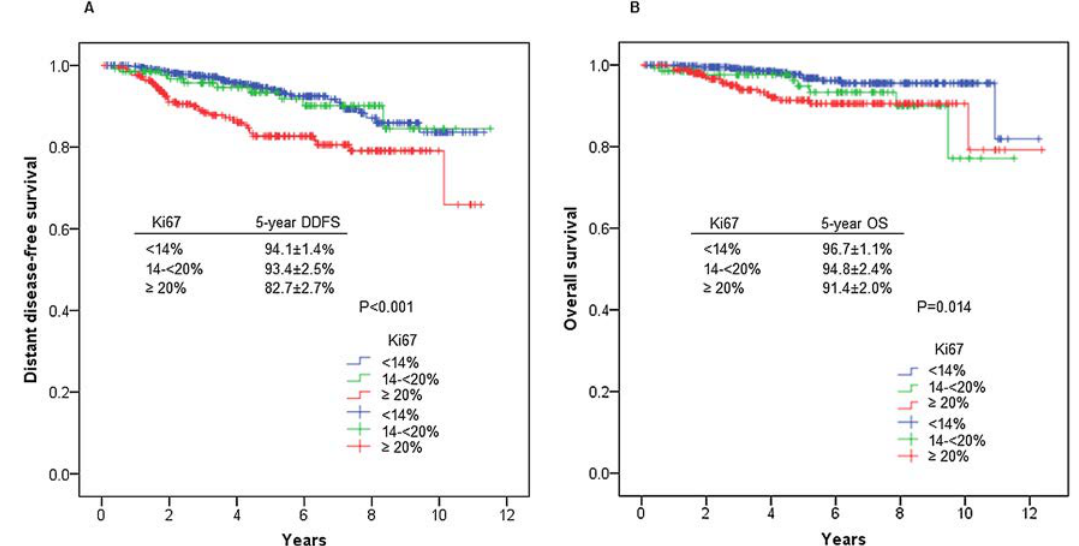
Figure 1 Distant disease-free (A) and overall survival (B) in 794 women with breast cancer according to Ki67 expression level. Table 2 Univariate analysis of distant disease-free survival and overall survival Distant disease-free survival Overall survival Covariate Hazard ratio (95% CI) p value Hazard